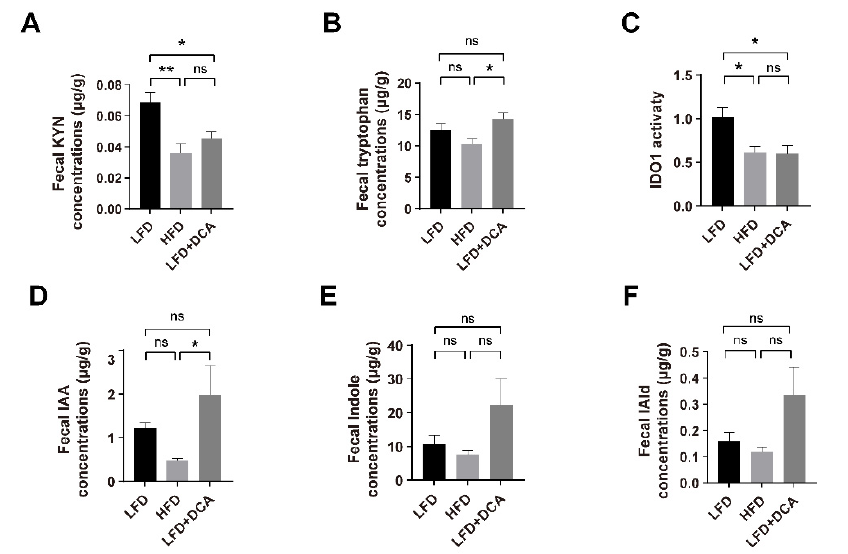
Figure 5. An HFD or DCA diet induces changes in the tryptophan metabolism. ( A – F ) Faecal KYN concentrations ( A ), tryptophan concentrations ( B ), IDO1 activity (KYN/tryptophan) ( C ), IAA concentrations ( D ), Indole concentrations ( E ), and IAld concentrations ( F ) in different groups (n = 5). Data are shown as the mean ± SEM. KYN, kynurenine; IDO1, indoleamine 2,3-dioxygenase 1; IAA, indole-3-acetic acid; IAld, indole-3-aldehyde. * p < 0.05; ** p < 0.01; ns, no significant difference.